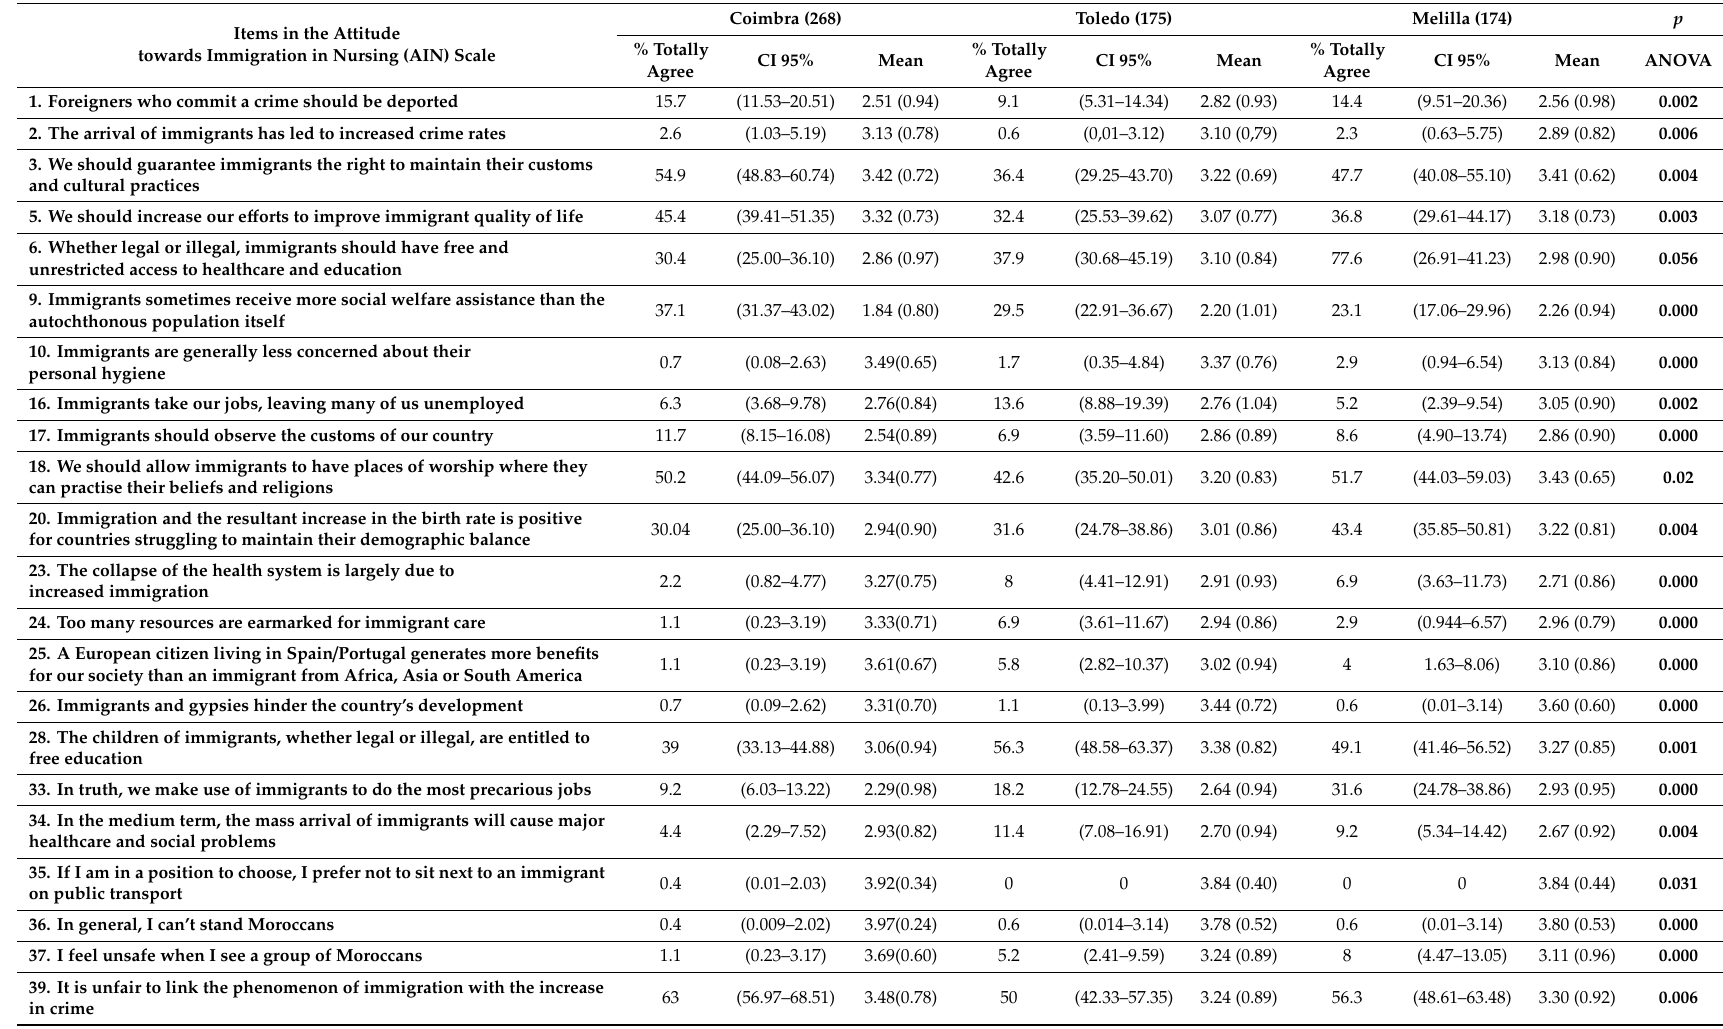
Table 2. Degree of agreement with items in the Attitude towards Immigration in Nursing (AIN) scale organized by university where students are enrolled. Coimbra (268) Toledo (175) Melilla Items in the Attitude towards Immigration in Nursing (AIN) Scale